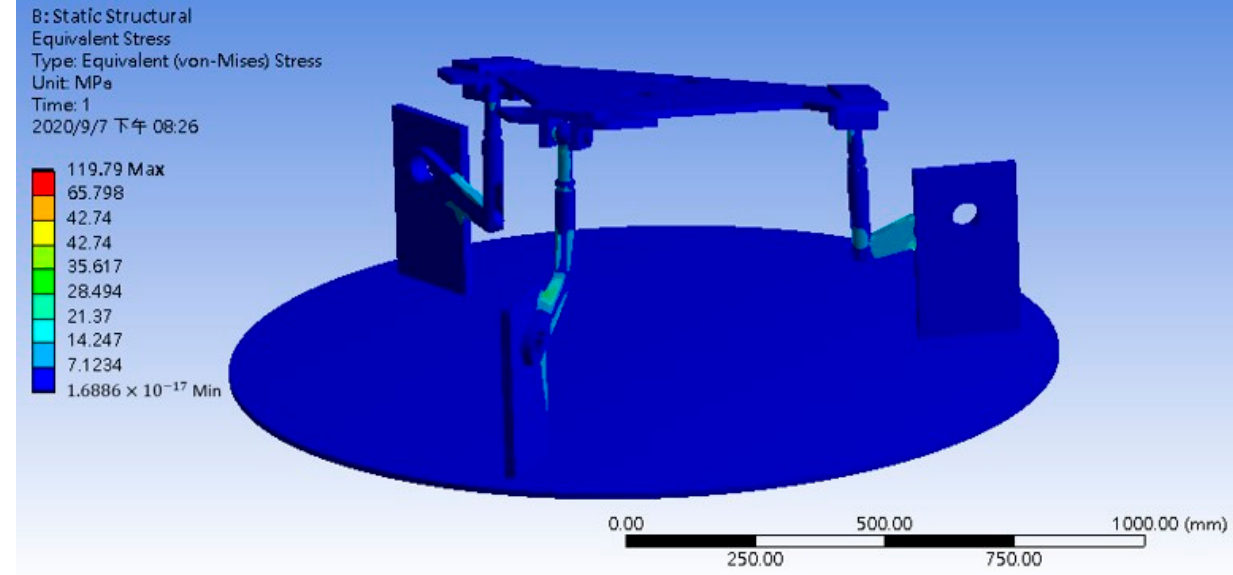
Figure 14. The stress trend chart of the roll motion. For the pitch motion, the platform motion angles were 0°, 10°, and 20°. The simula- tion results showed that the maximum stress was located at the angle of 20° with a maxi- mum stress of 119.79 MPa. The maximum stress analysis result is shown in Figure 15. The pitch motion stress trend is shown in Figure 16.